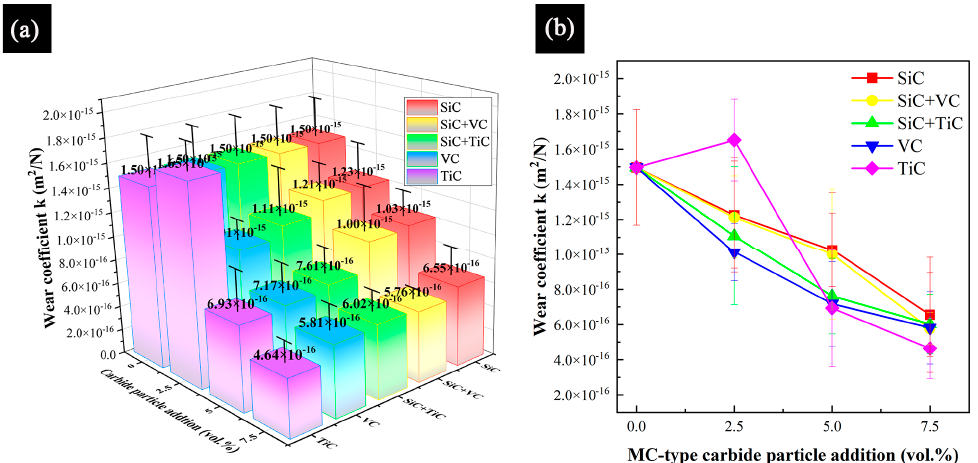
Figure 11. The effect of the volume fraction and type of additive MC-type carbides on the variation of κ wear coefficients of prepared HSS MMCs. ( a ) Histograms of wear coefficients vs. volume fraction and type of carbides; ( b ) Curves of wear coefficients vs. MC-type carbides addition.